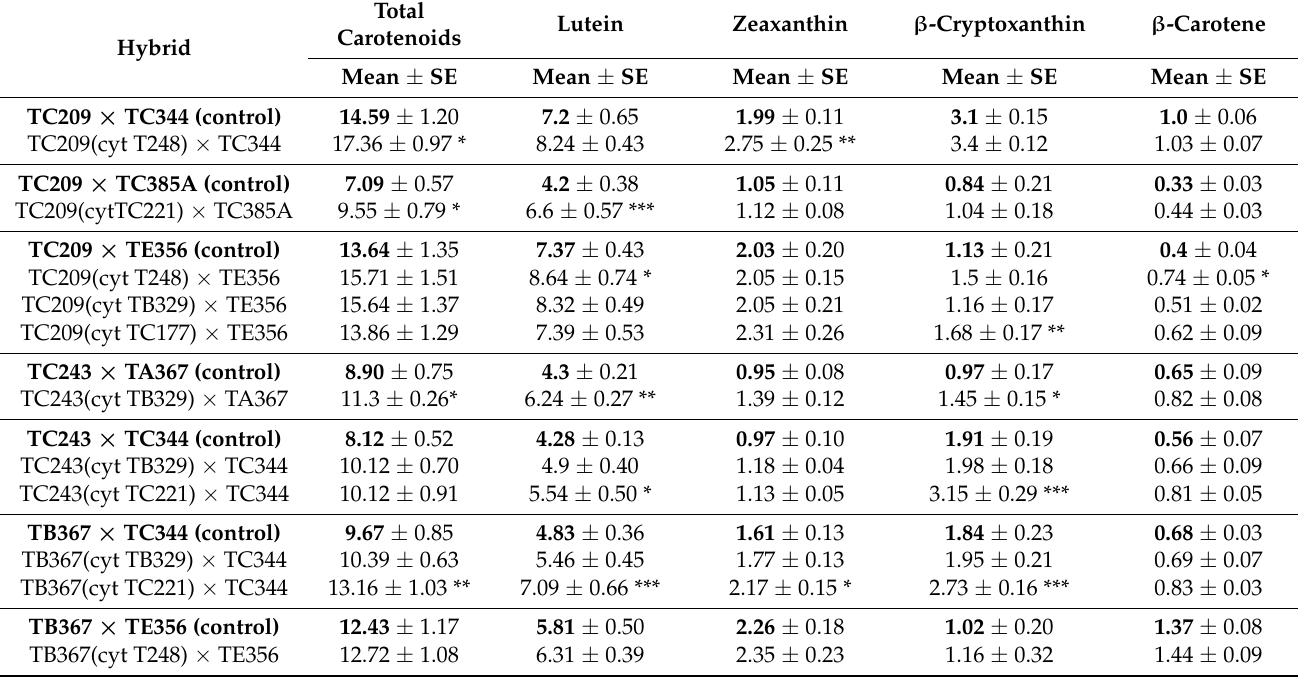
Table 11. Hybrids that exceeded the control (the hybrid using the original cytoplasm) for the targeted carotenoids ( µ g/g)—ANOVA